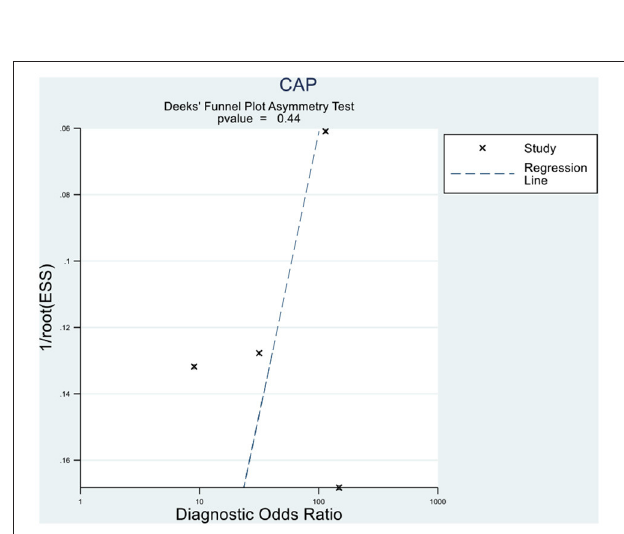
FIGURE 7 | Deeks’ funnel plot asymmetry test to evaluate the publication bias of MRI-PDFF and TE-CAP (S0 vs.